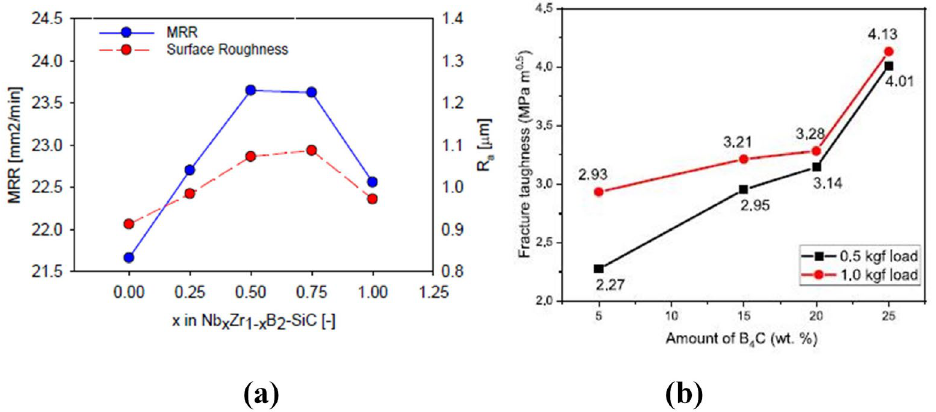
Figure 2. EDM properties of boride-based UHTCMCs. ( a ) MRR and Surface Roughness Ra for different boride 20 vol.% SiC composite. Reprinted/adapted with permission from Ref. [77]. Copyright 2013, Elsevier. ( b ) Fracture toughness of ZrB 2 -B 4 C composite with different composition. Reprinted/adapted with permission from Ref. [83]. Copyright 2022, Elsevier.